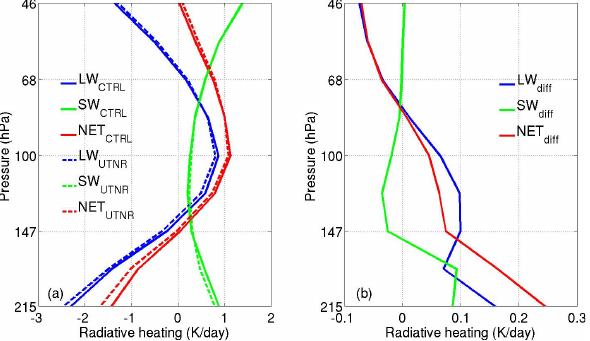
Fig. 4. (a) 4-yr averaged radiative heating rates (Kday − 1 ) in the in- ner tropics (10 ◦ S–10 ◦ N). Solid (dashed) blue is LW radiative heat- ing in the WRF CTRL (UTNR) run. Solid (dashed) green is SW radiative heating in the WRF CTRL (UTNR) run. Solid (dashed) red is the net (NET) of SW and LW radiative heating in the WRF CTRL (UTNR) run. (b) 4-yr averaged differences of radiative heat- ing rates (Kday − 1 ) between the WRF CTRL and UTNR runs in the inner tropics for LW (blue), SW (green) and NET (red).